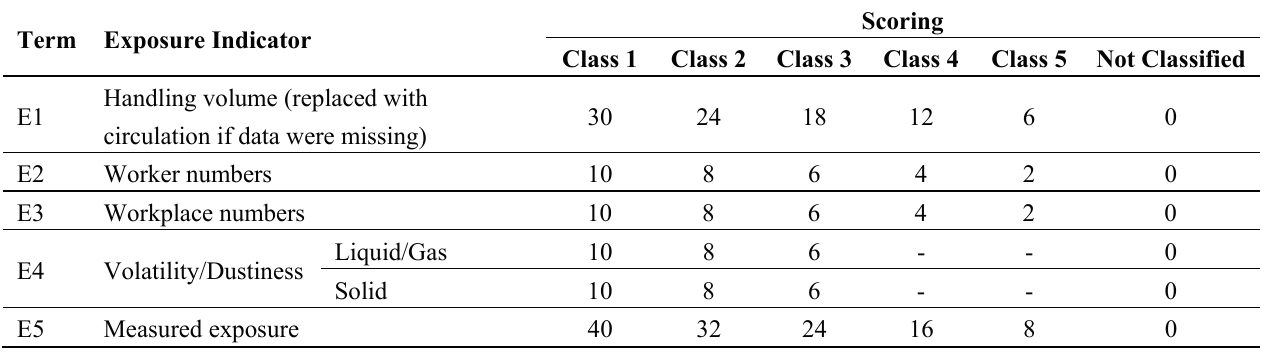
Table 4. Scoring for classification of exposure